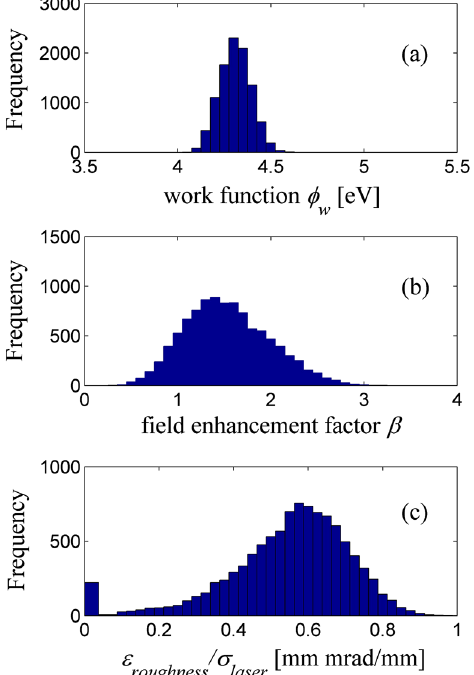
FIG. 2. 10 4 simulated fitting for model of Eq. (16) with 5% (rms) emittance data error: (a) histogram of work function fitting results, (b) histogram of field enhancement factor fitting results, and (c) histogram of roughness emittance fitting results at 50 MV = m